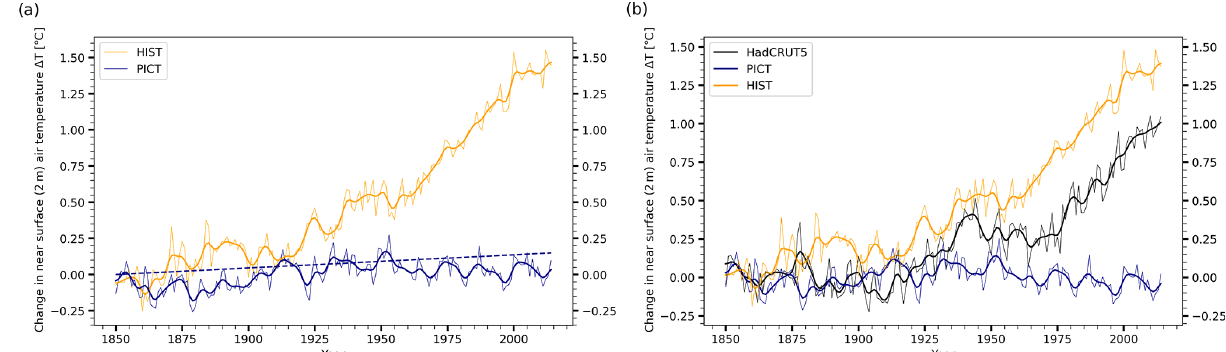
Figure 10. (a) Near-surface (2m) air temperature changes over the historic period and in the pre-industrial control simulation. Thick lines show the 10-year running means. The pre-industrial control simulation shows a residual drift of 0.00091 ◦ Cyr − 1 obtained from linear regression. (b) Both simulations have been corrected by subtracting the residual drift. The resulting simulated global warming over the period 1850 to 2014 is 1.4 ◦ C. In comparison to observational estimates from HadCRUT5 (Morice et al., 2021) warming is overestimated by 0.4K, likely due to fixed aerosols in the AWI-CM3 prototype.